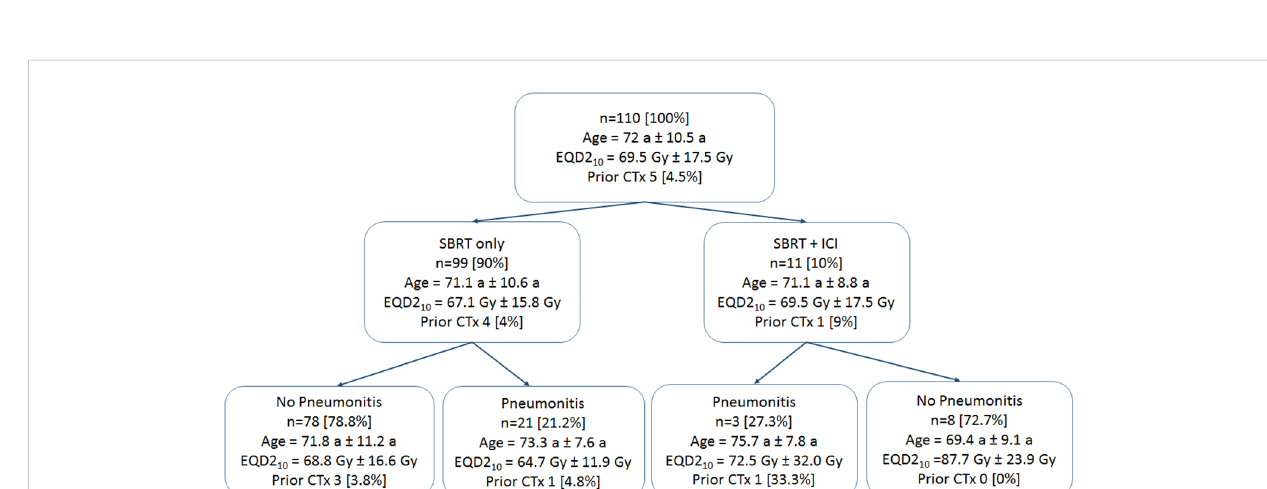
FIGURE 1 Patient data groups. Patient mean age and standard deviations are provided. Prescription doses are given in mean values and standard deviations of equivalent uniform doses for an a / b of 10 Gy (EQD2 10 ). The number of patients who received prior chemotherapy (CTx) is